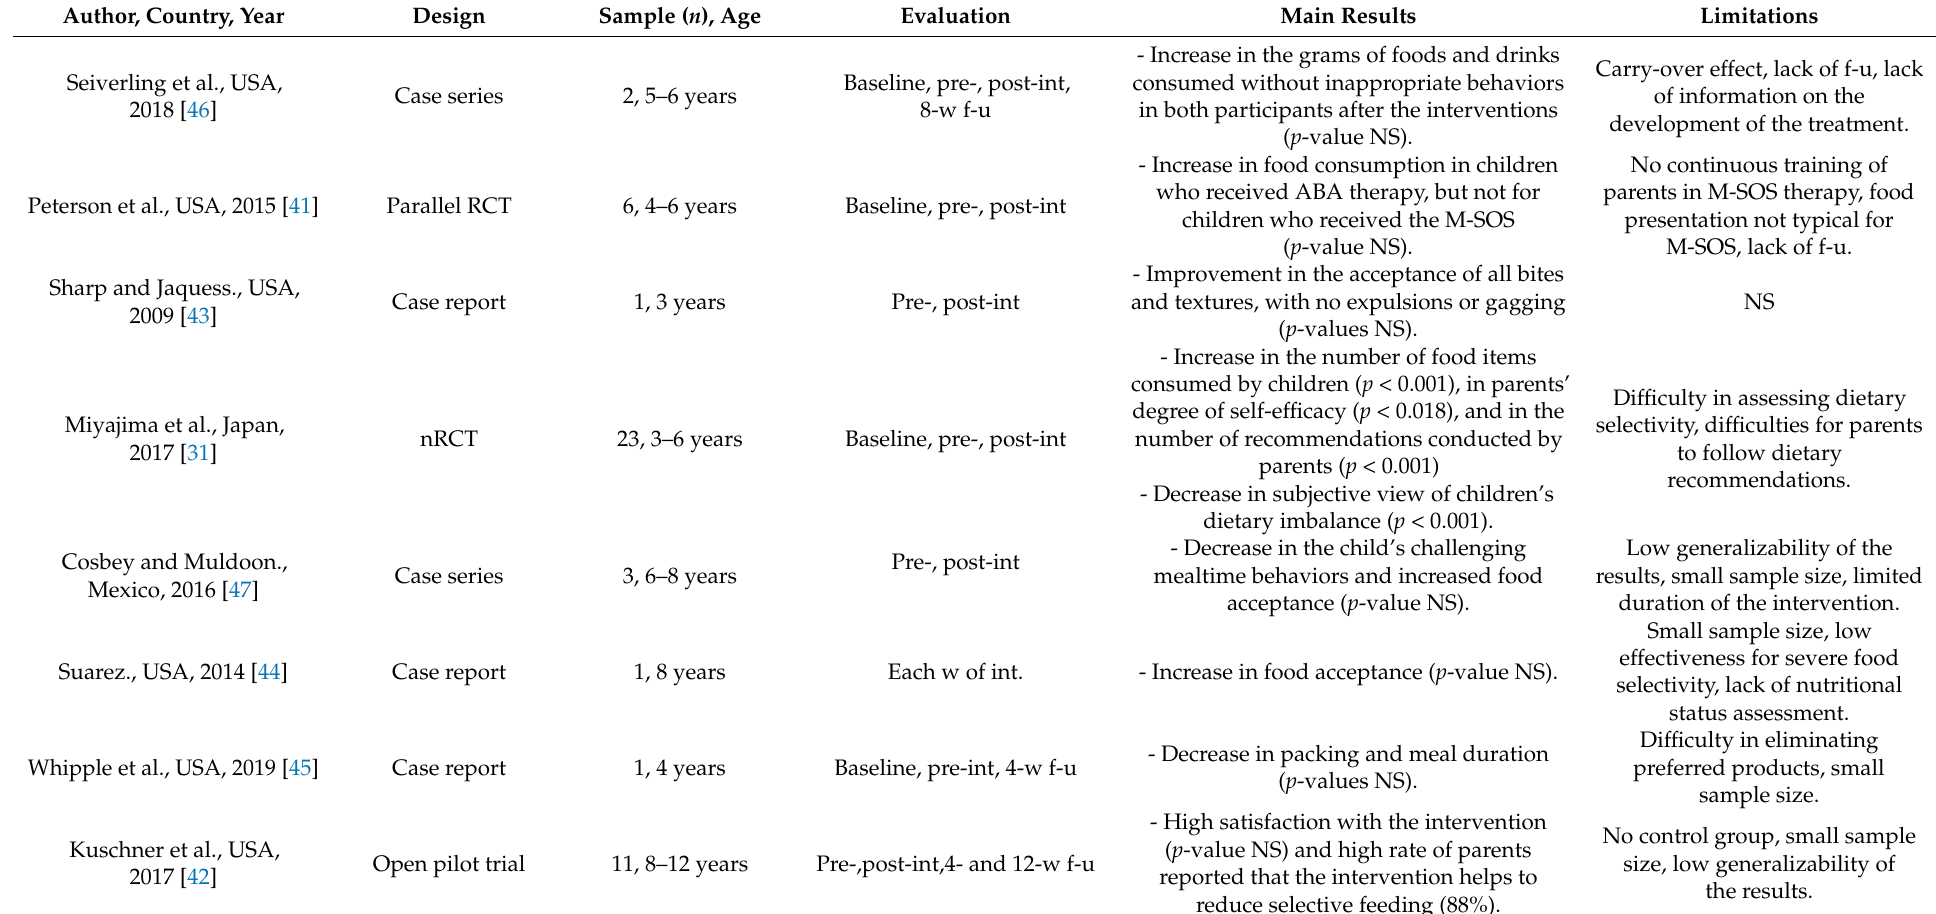
Table 1. Characteristics of the studies included in the scoping